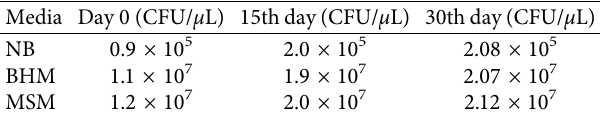
Table 2: Monitoring the planktonic growth of Pseudomonas